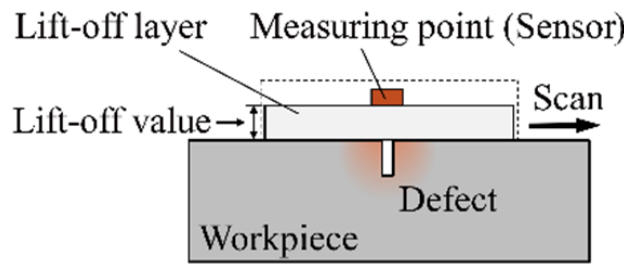
Figure 1. The lift-off layer and lift-off value in MFL testing.